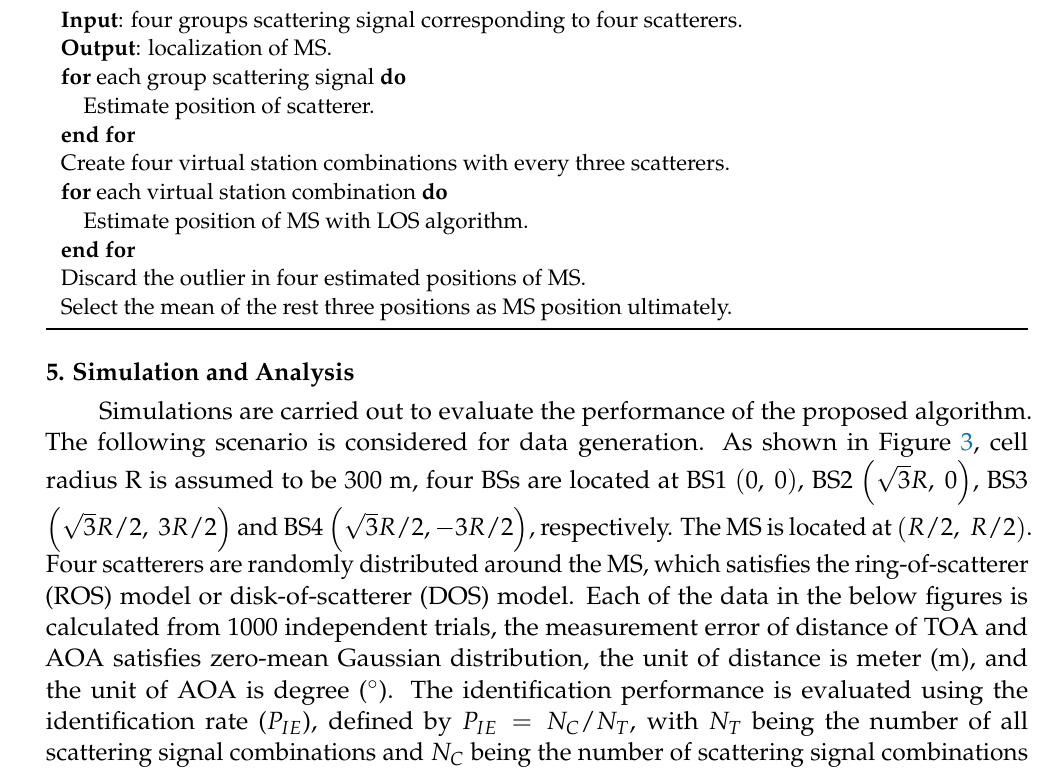
Algorithm 4 : Virtual station localization algorithm